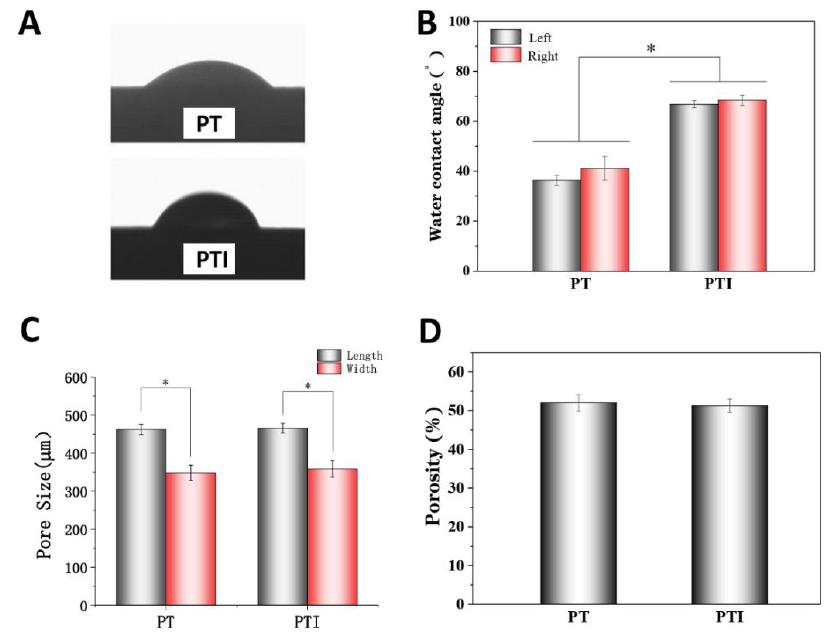
Figure 2. Water contact angle, pore size, and porosity of PT and PTI scaffolds. ( A , B ) Water contact angle, ( C ) average pore size, and ( D ) porosity of the two groups of scaffolds ( n = 3, * p < 0.05). The elastic modulus and compressive strength of the scaffolds were investigated. The elastic modulus of the PT scaffold was 44.42 ± 2.11 MPa, which was significantly higher than that of the PTI scaffold (28.67 ± 1.88 MPa) ( p < 0.001) as shown in Figure 3A. In addi- tion, the compressive strength of the PT scaffold (1.45 ± 0.28 MPa) was greater than that of the PTI scaffold (0.32 ± 0.12 MPa) ( p < 0.01). Combined with the stress – strain curve as shown in Figure 3B, we concluded that the compressive strength of the PT scaffold was significantly reduced after the incorporation of ICA. The standard curve of ICA was plot- ted using OD 270 detection, provided in Figure 3C. Similarly, the ICA release kinetics of the PTI scaffold can be obtained. In the first 10 days, ICA showed the characteristics of burst release and the cumulative release of 0.23 mg/mL/0.1 g PTI scaffold, reaching 57.5% of the total ICA load as shown in Figure 3D. In the following 11 – 80 days, the release velocity of ICA lowered down significantly, and the cumulative release of ICA reached 0.38 mg/mL/0.1 g, accounting for 95% of the total ICA load.